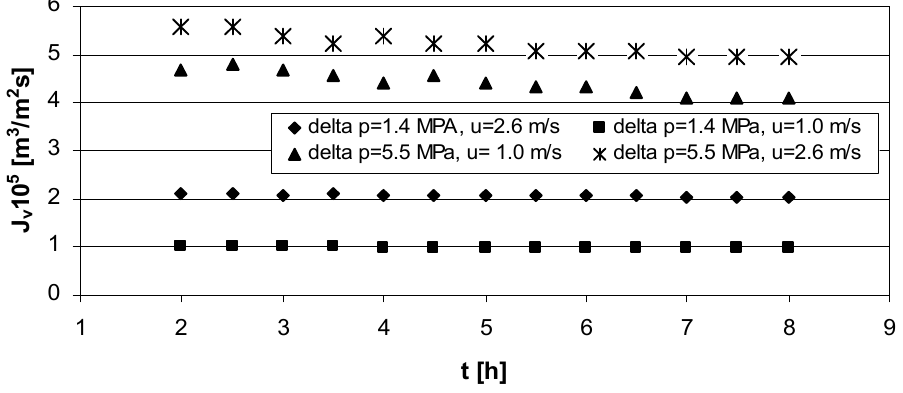
Figure 2. Permeate flux through clean membrane vs. time for: series 1, 2—transmembrane pressure Δ p = 1.4 MPa, and cross flow velocity u = 2.6 m/s and u = 1.0 m/s respectively and series 3, 4—transmembrane pressure Δ p = 5.5 MPa, cross flow velocity u = 1.0 m/s and u = 2.6 m/s